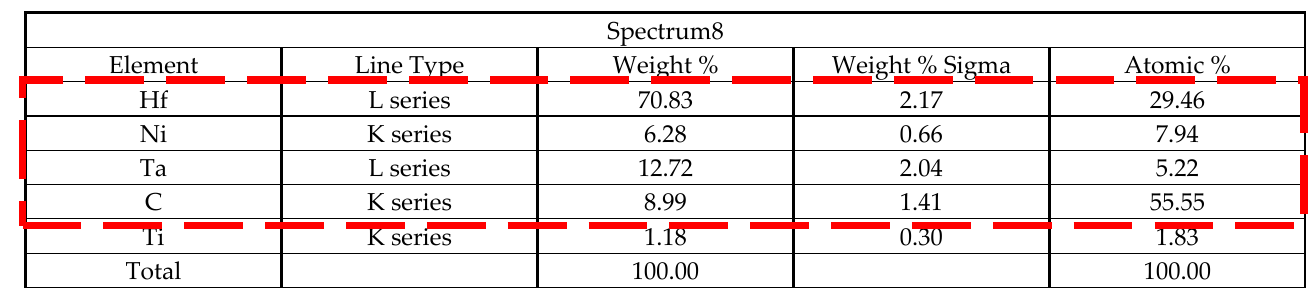
Table 2. The chemical composition of the superalloy in Spectrum 6. Table 3. The chemical composition of the superalloy in Spectrum 8.